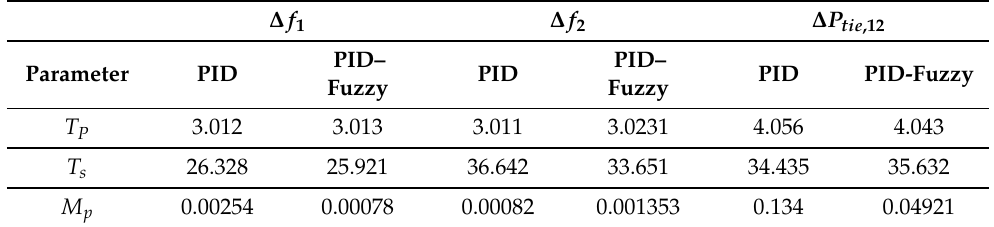
Table 5. Case 1: Dynamic performance characteristics of the two controllers for a 0.2 pu change in area 1. ∆ f ∆ f 1